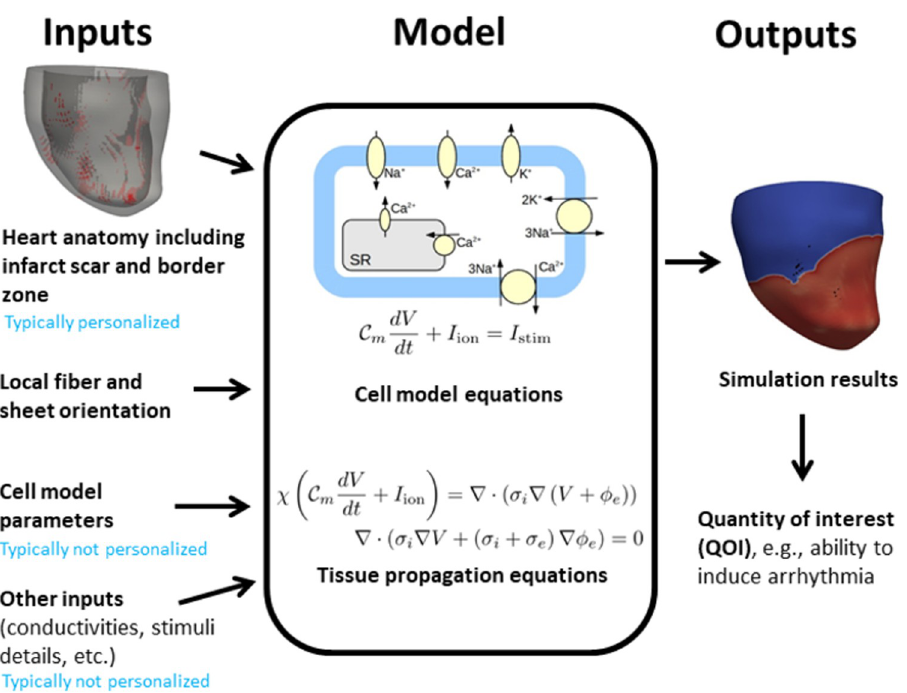
Fig 1. Overview of cardiac electrophysiological